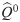
Fitting fMRI data to infer cortico-cortical connectivity.A Empirical FC, namely Q^0 and Q^τ, averaged over 25 subjects for BOLD signal recorded during rest. B Autocovariances (grey curves, with a log y-axis) as a function of the time shift τ. From the mean curve (red) the time constant for the ND model is estimated: τx = 5.3 s. The inset represents the autocovariances with a standard y-axis. C Variability of similar decay time constants to τx in B for individual cortical area. D SC mask of weights to tune (black pixels), corresponding to the strongest connections of the dwMRI matrix in Fig 6B thresholded to obtain 32% density. E Evolution of the Q error during the optimization. The black line indicates the rate of change of C. F EC corresponding to the estimated C matrix. G Match between empirical and reconstructed Q matrices for the optimization with τest = 4 s while the connections for the mask in D. For both Q0 and Qτ, the blue dots correspond to tuned connections, the black crosses to non-diagonal untuned connections and the cyan dots to diagonal connections. The Pearson correlation coefficient between matrix elements are given above each plot. H Weak correlation between the symmetric part of the estimated C and Q^0, indicating a strong network effect.